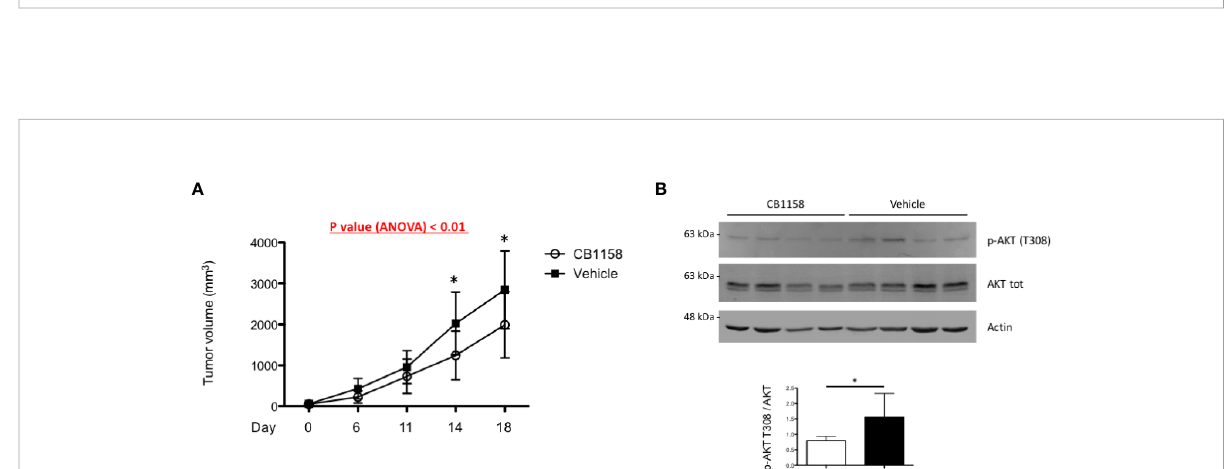
FIGURE 5 Pharmacological arginase inhibition reduces myeloma growth in immunocompromised recipient mice. (A) 2x10 6 H929 cells were implanted subcutaneously in the fl ank of Rag – / – g c – / – mice. When tumors were palpable, mice were randomly assigned to two groups and treated with the arginase inhibitor CB1158 (100 µg/g body weight) or vehicle by oral gavage bis in die for 18 days. Growth of subcutaneous tumors was measured by caliper and represented as mean size (mm 3 ) ± s.d. (n = 7 mice/group). *p<0.05, Bonferroni posttests after 2-way ANOVA. (B) Representative immunoblot analyses of protein extracts from individual tumor biopsies at the end of the study. Expression of total and phosphorylated AKT at threonine 308 (upper panel) are shown (actin B serving as loading control). Histogram (lower panel) shows quanti fi cation of phospho-ATK relative to total protein (n = 7 mice/group). Bars indicate average ± s.d. *p<0.05, unpaired t -test.